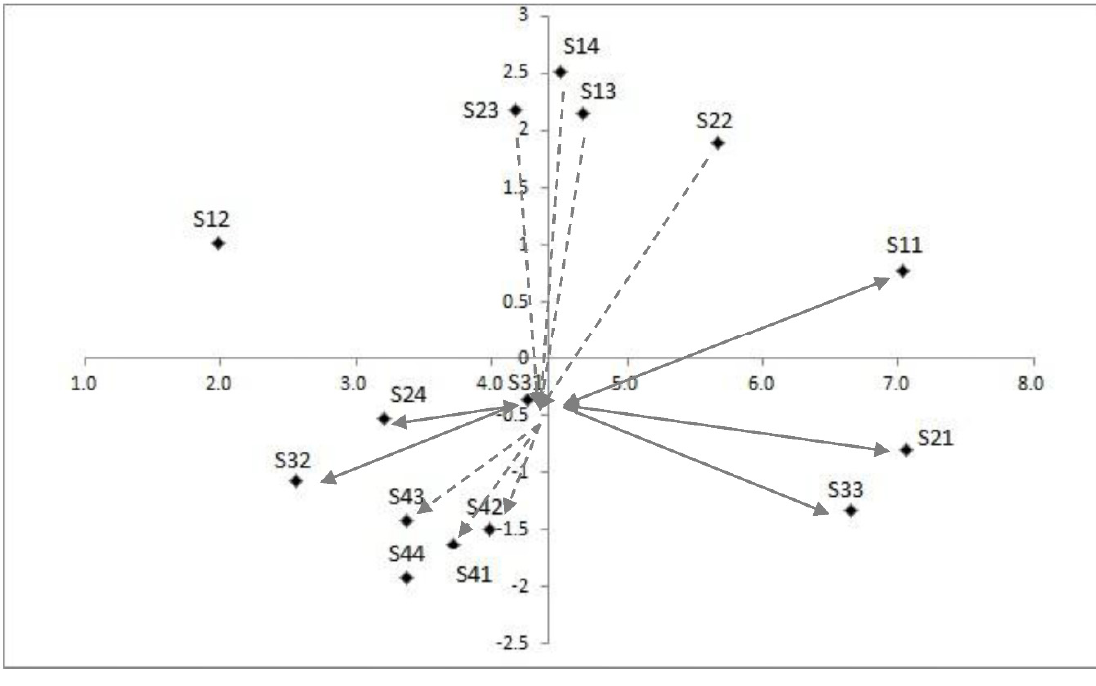
Figure A9. Casual Diagram between S31 and Other Criteria.